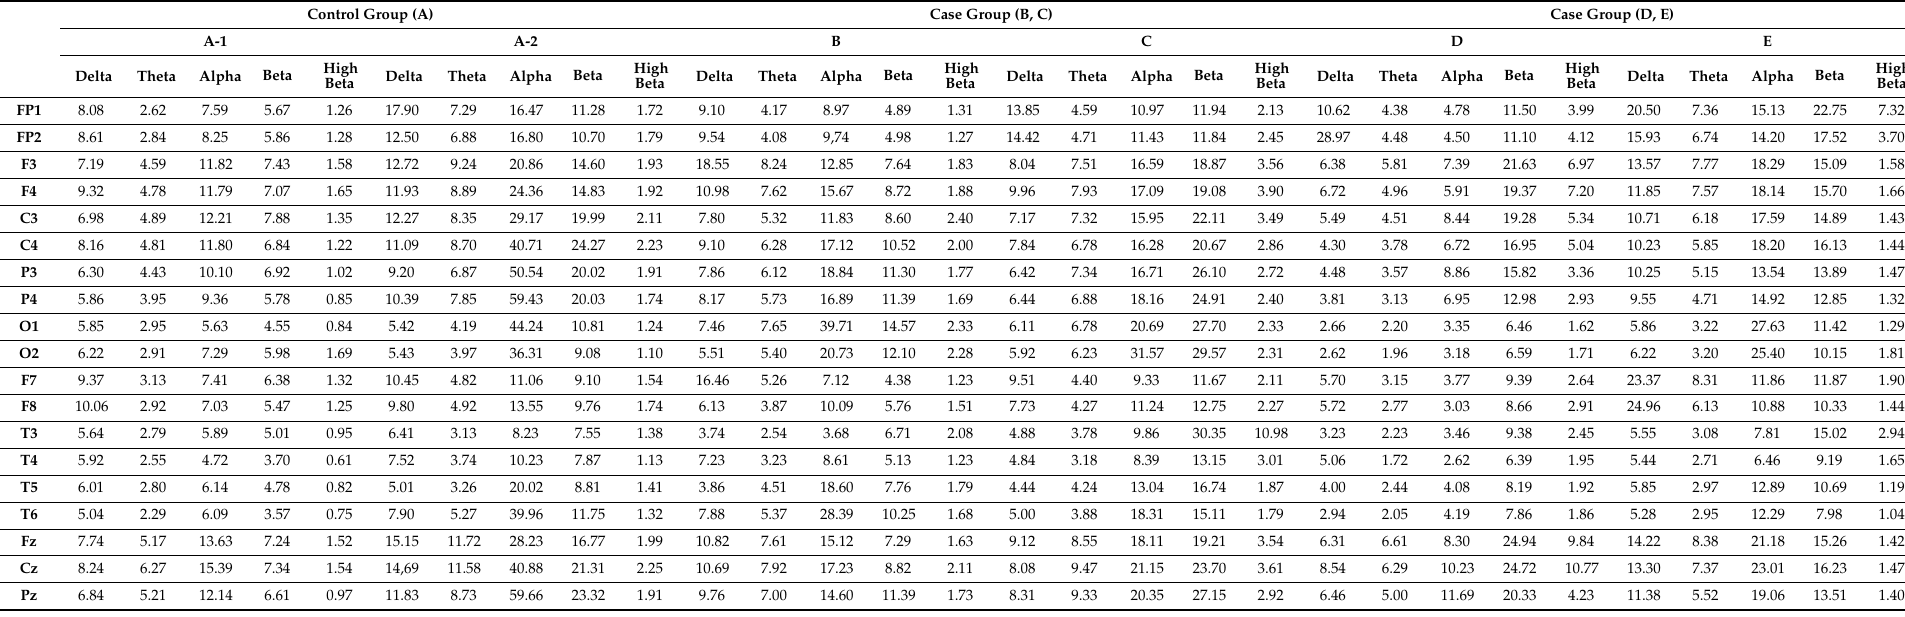
Table 4. Groups’ EC FFT absolute power data